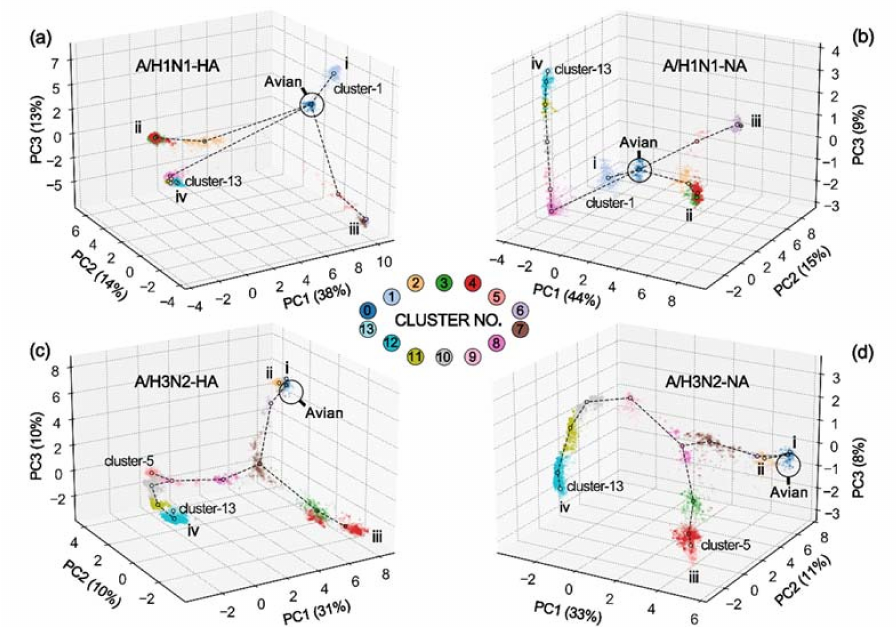
Figure 3. Hierarchical clustering analysis based on principal component analysis (PCA) matrices with dimensionality reduction. ( a ) A/H1N1-HA; ( b ) A/H1N1-NA; ( c ) A/H3N2-HA; ( d ) A/H3N2-NA. Each subset is divided into 14 clusters (indicated in Figure 2), which are grouped into different evolu- tion branches (i, ii, iii, and iv) starting from the “Avian” cluster. The X-axis, Y-axis, and Z-axis represent the projections to the first three principal components (PCs): PC1, PC2, and PC3, respectively. Table 1. Branch evolution distances of hemagglutinin (HA) and neuraminidase (NA). Branch